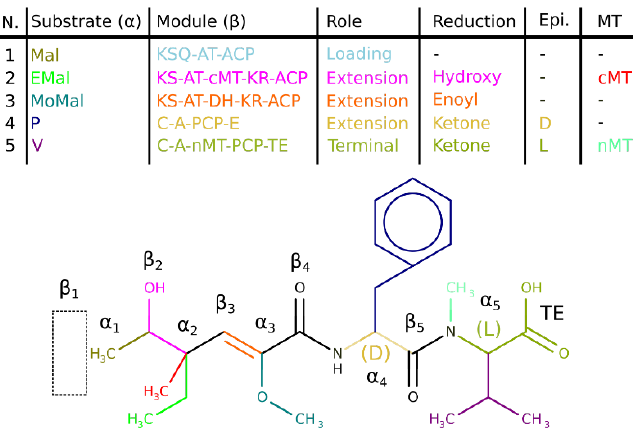
Figure 6. Scaffold generation for a hypothetical mixed cluster. The NRP positions are marked α for the N-C-rest and β for the ketone following the PK nomenclature. The substrate specificity leads to a modification in the α -position. The module arrangement results in a modification in the β -position. Each parameter and corresponding modification is color-coded. Loading modules do not add a carbon atom in the β -position, marked with a dashed box ( β 1 ). Terminal modules add an additional carboxyl (TE) or hydroxyl (TD) substructure to the scaffold. Epi. refers to the epimerization of the NRP substrates, resulting in L- or D-forms.